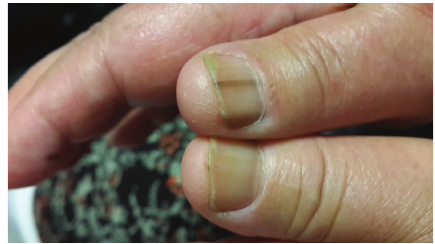
Figure 1: Melanonychia of the upper extremity nails.